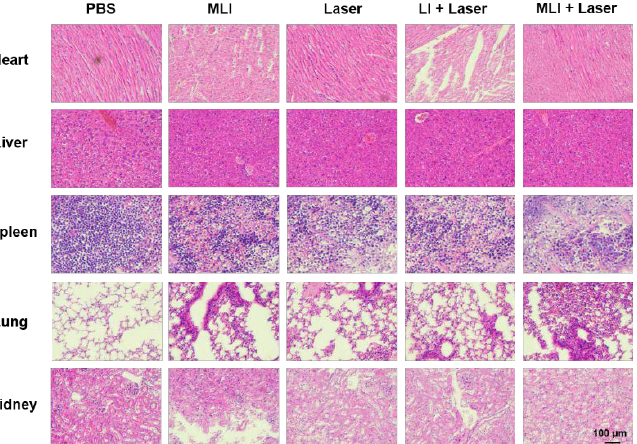
Figure 6. Representative H&E-stained images of the major organs (heart, liver, spleen, lung and kidney) extracted from mice with different treatment groups. (Scale bars: 100 μm).